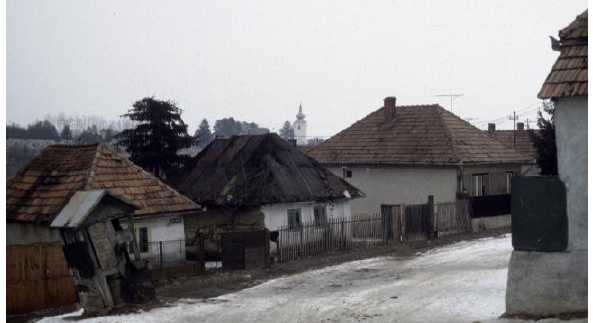
Figure 1. Traditional urban